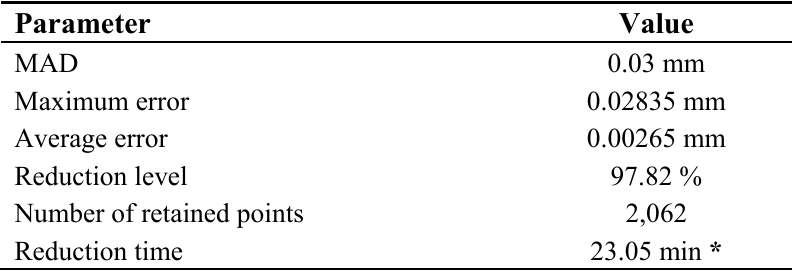
Table 6. The results of point data reduction.